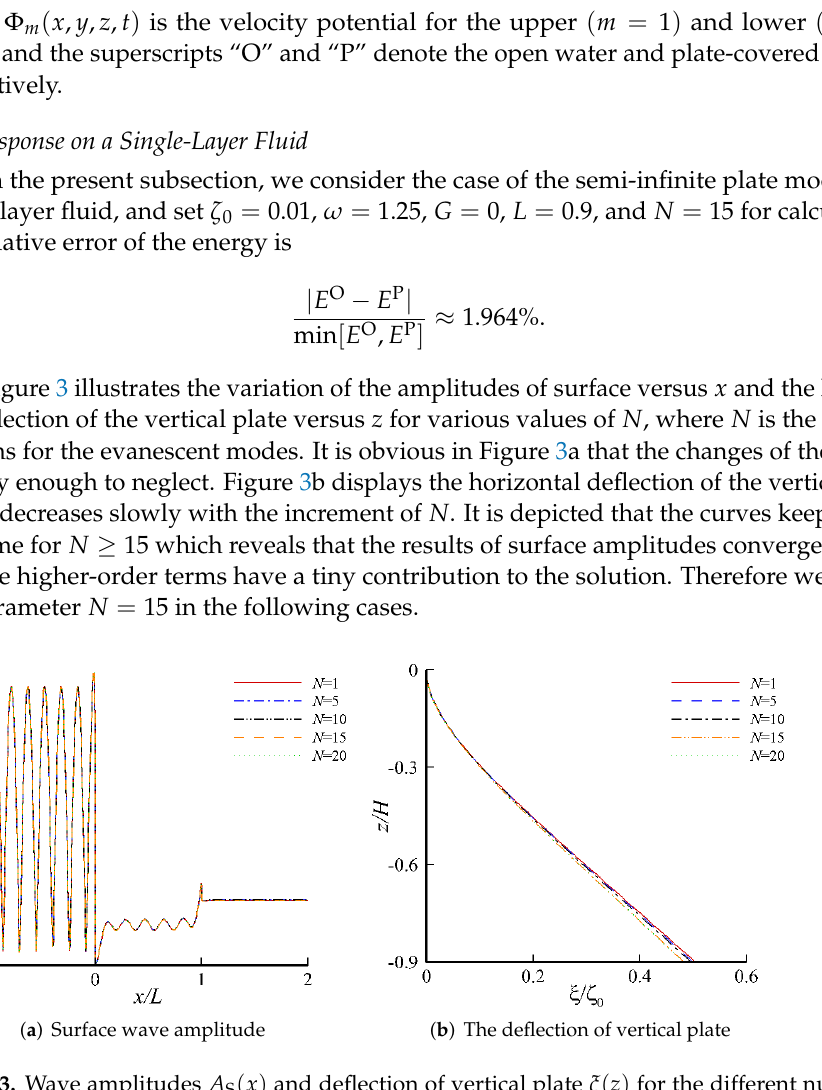
Figure 3. Wave amplitudes A S ( x ) and deflection of vertical plate ξ ( z ) for the different number of terms N